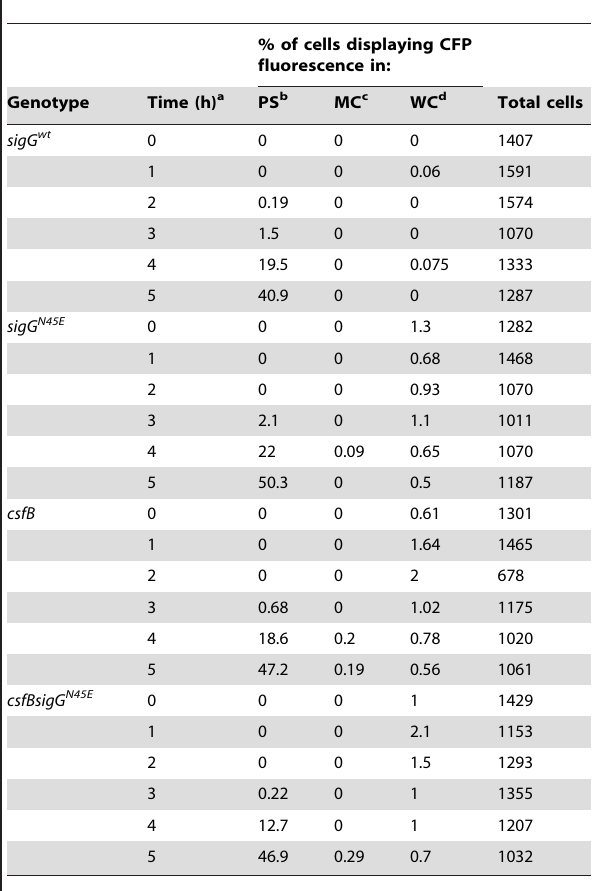
Table 1. Localization of CFP expressed from the s G -controlled P sspE